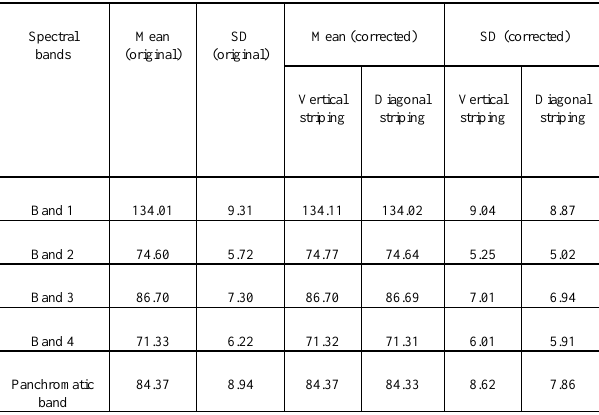
Table 3. Comparison of the results of striping noise removal in the images acquired by CBERS 2 CCD Camera In addition, the diagram of columns mean for correcting single columns in band 2 images is shown in Figure 11. As it can be seen, the noise removal process reduces the changes in the diagram of detector data mean in defective columns. This can be well seen by comparing Figure 11 (a) and 11 (b). The diagram 11 (a) shows the mean of columns in the original images and 11 (b) shows the graph after noise removal.